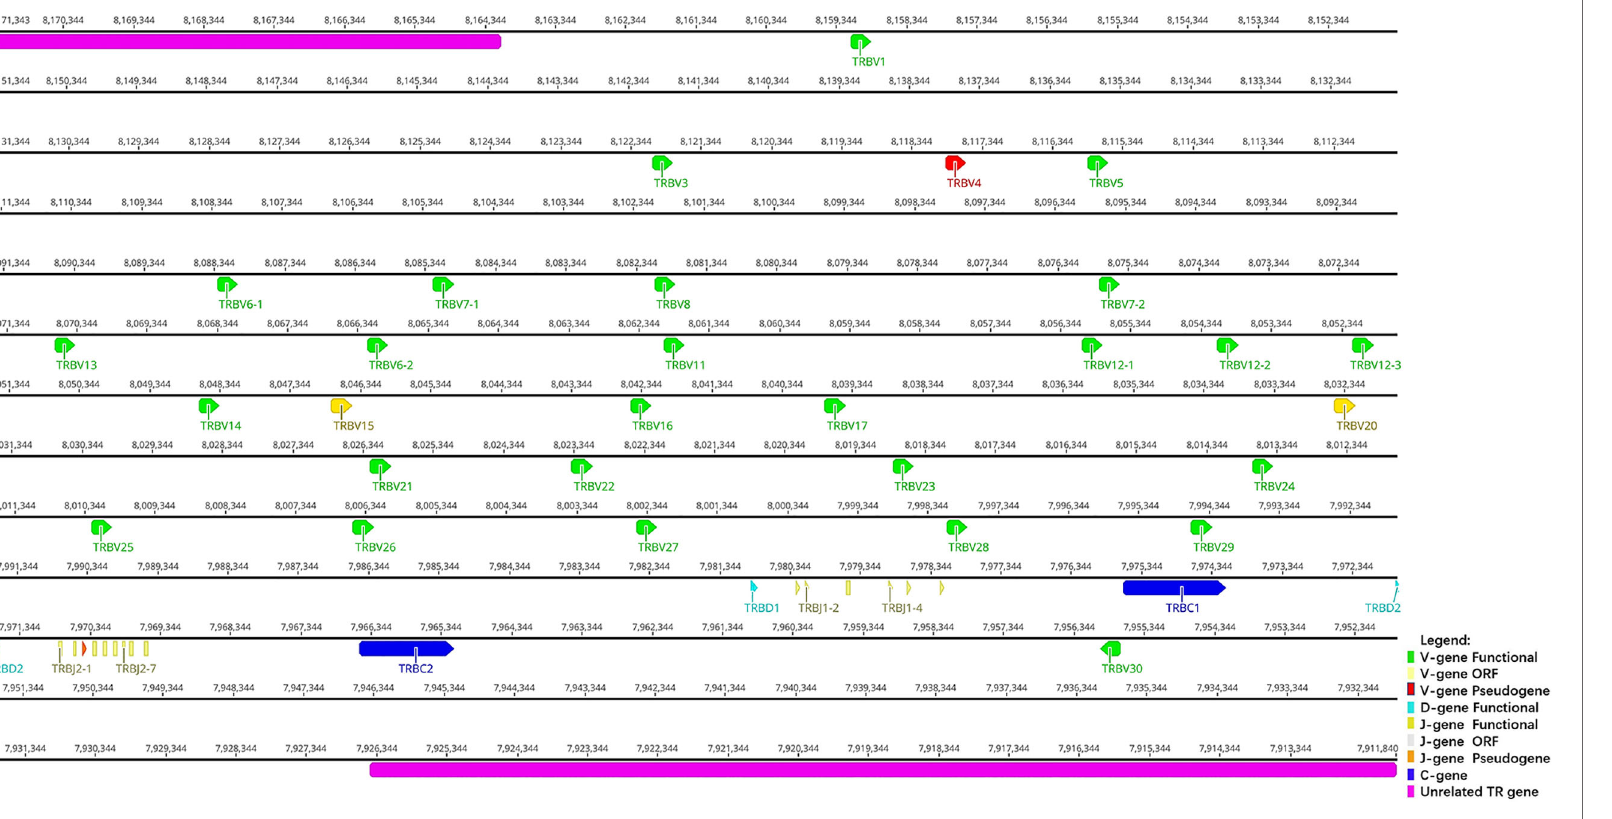
FIGURE 4 | The schematic representation of the genomic organization of the bat TRB locus. The diagram shows the position of all the related and unrelated TRB genes according to nomenclature. The L-part and RSSs are not shown. The arrows indicate the transcriptional orientation of the genes. The number represents the speci fi c location of the genes in chromosome 26 of Rhinolophus ferrumequinum